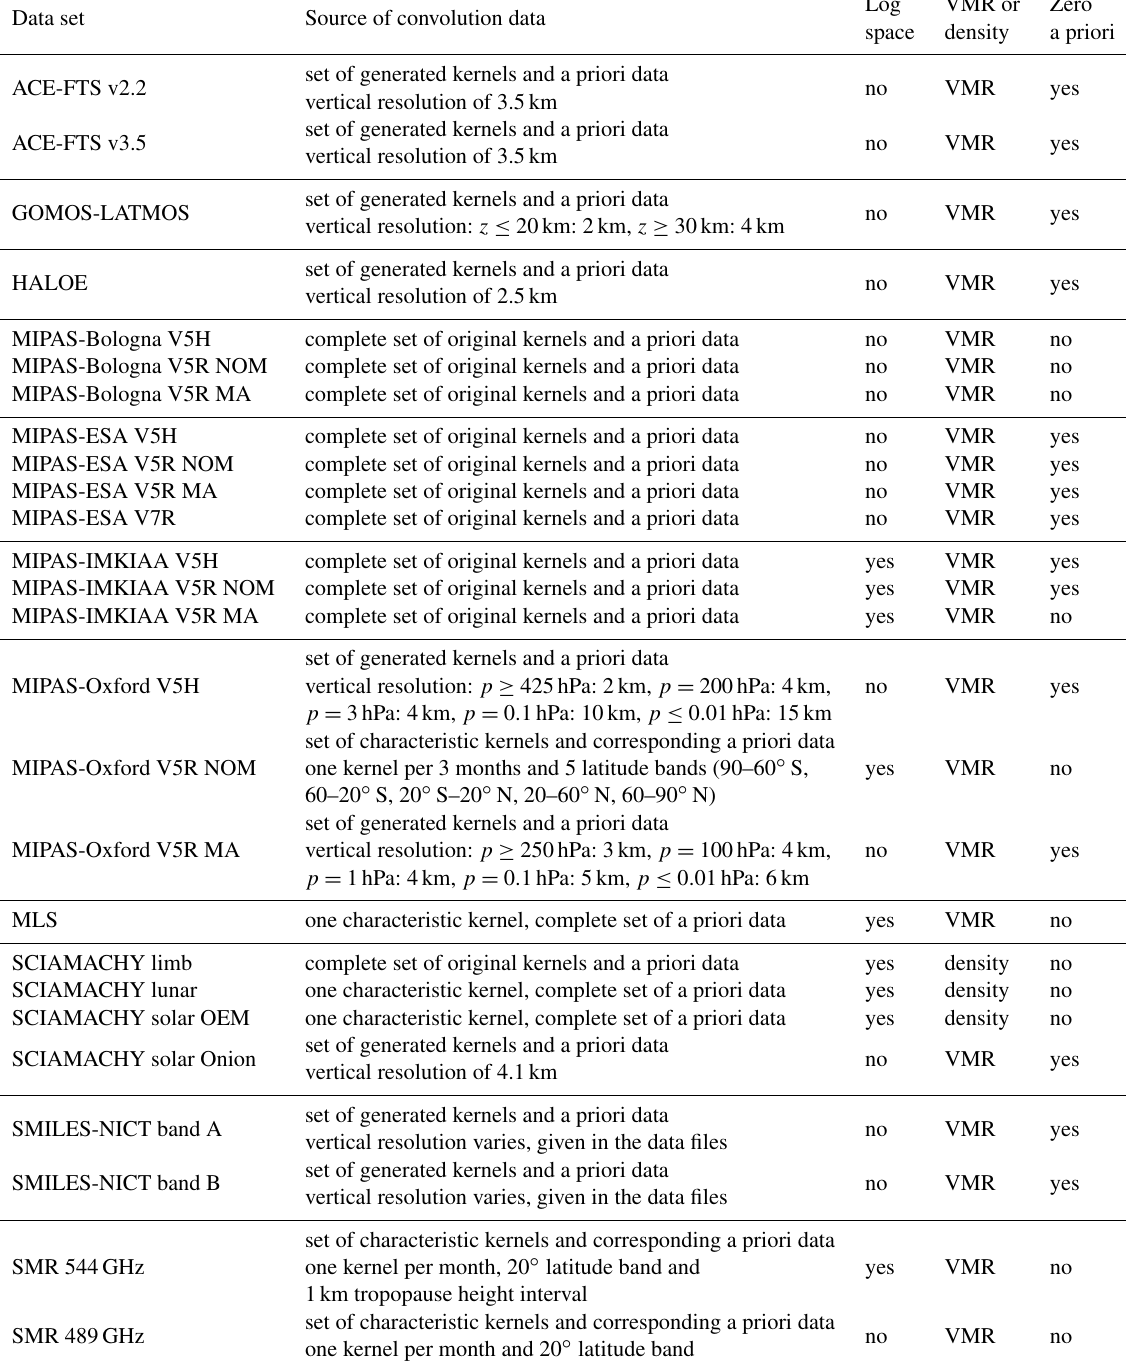
Table 3. Sources and characteristics of the convolution data used in the comparisons. Data set ACE-FTS